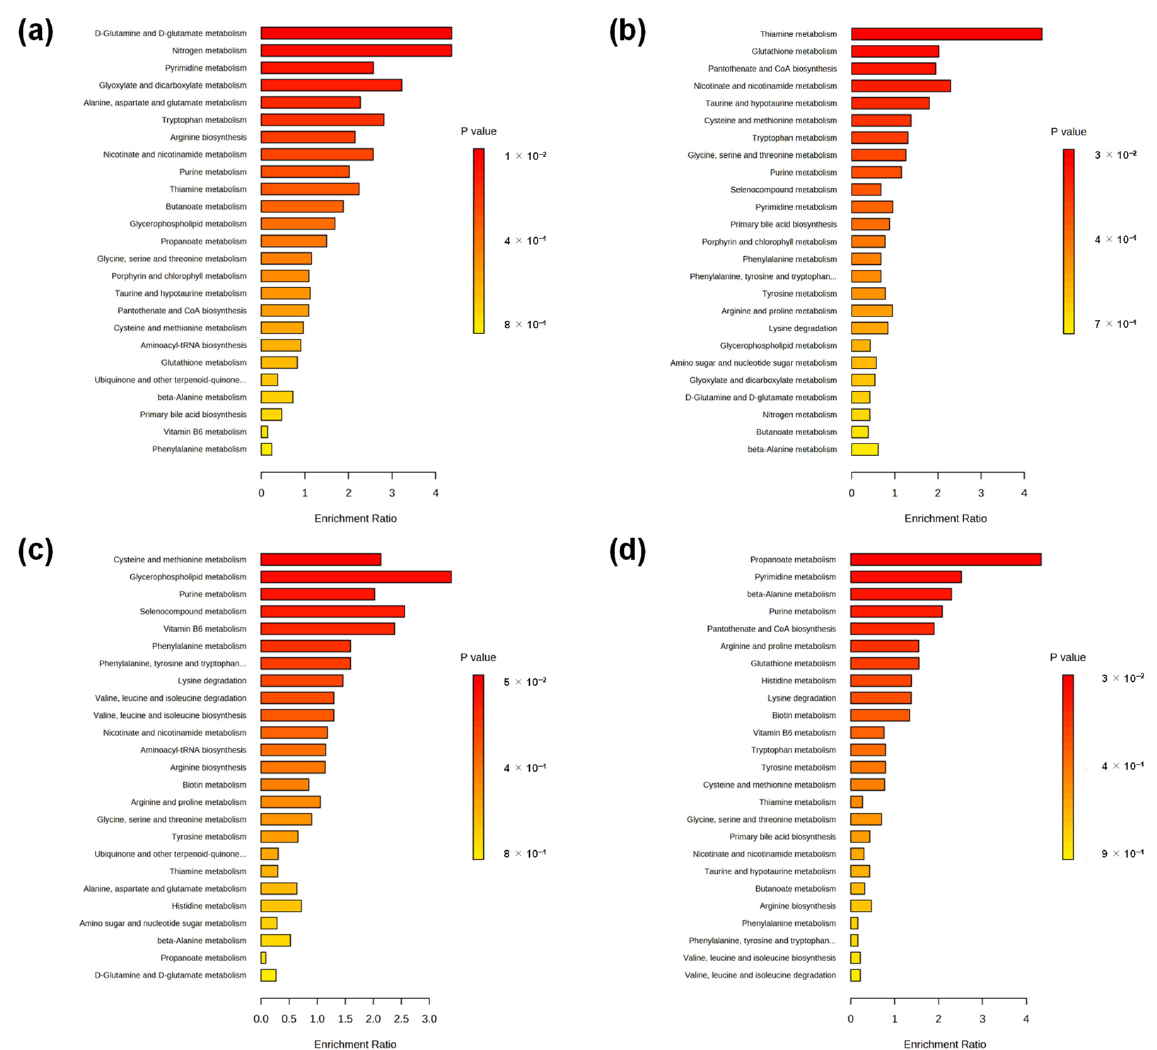
Figure 5. Enrichment analysis between depressive and nondepressive episode groups. In each panel, pathways are aligned according to p -values, and the length of each bar represents the enrichment ratio. Analysis results for ( a ) 3-, ( b ) 6-, ( c ) 9-, and ( d ) 12-month stays are shown.